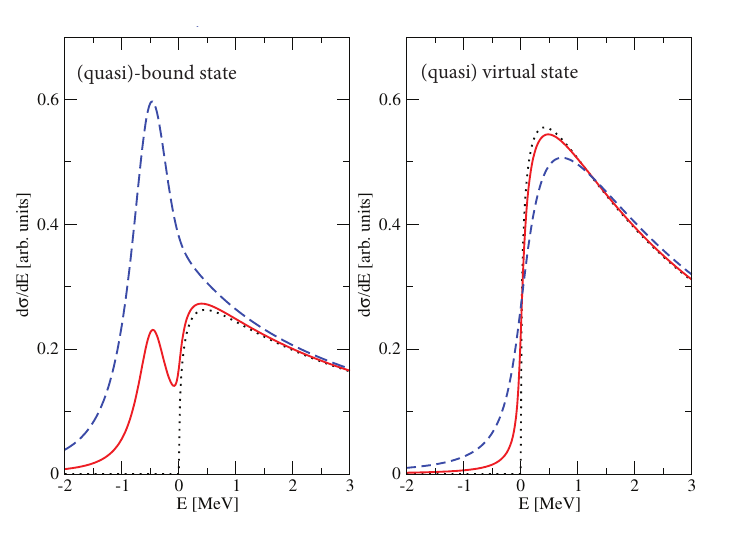
Figure 3. Lineshapes that emerge naturally for molecular states with unstable constituents. The curves were produced using the formulas of Ref. [25] for a pole located 0.5 MeV below the threshold on the first (second) sheet with respect to the studied channel. For the dotted, solid and dashed lines a width of the constituent of 0, 0.1 and 1 MeV was assumed. Furthermore an inelastic width of 1.5 MeV was introduced — see Ref. [3] for